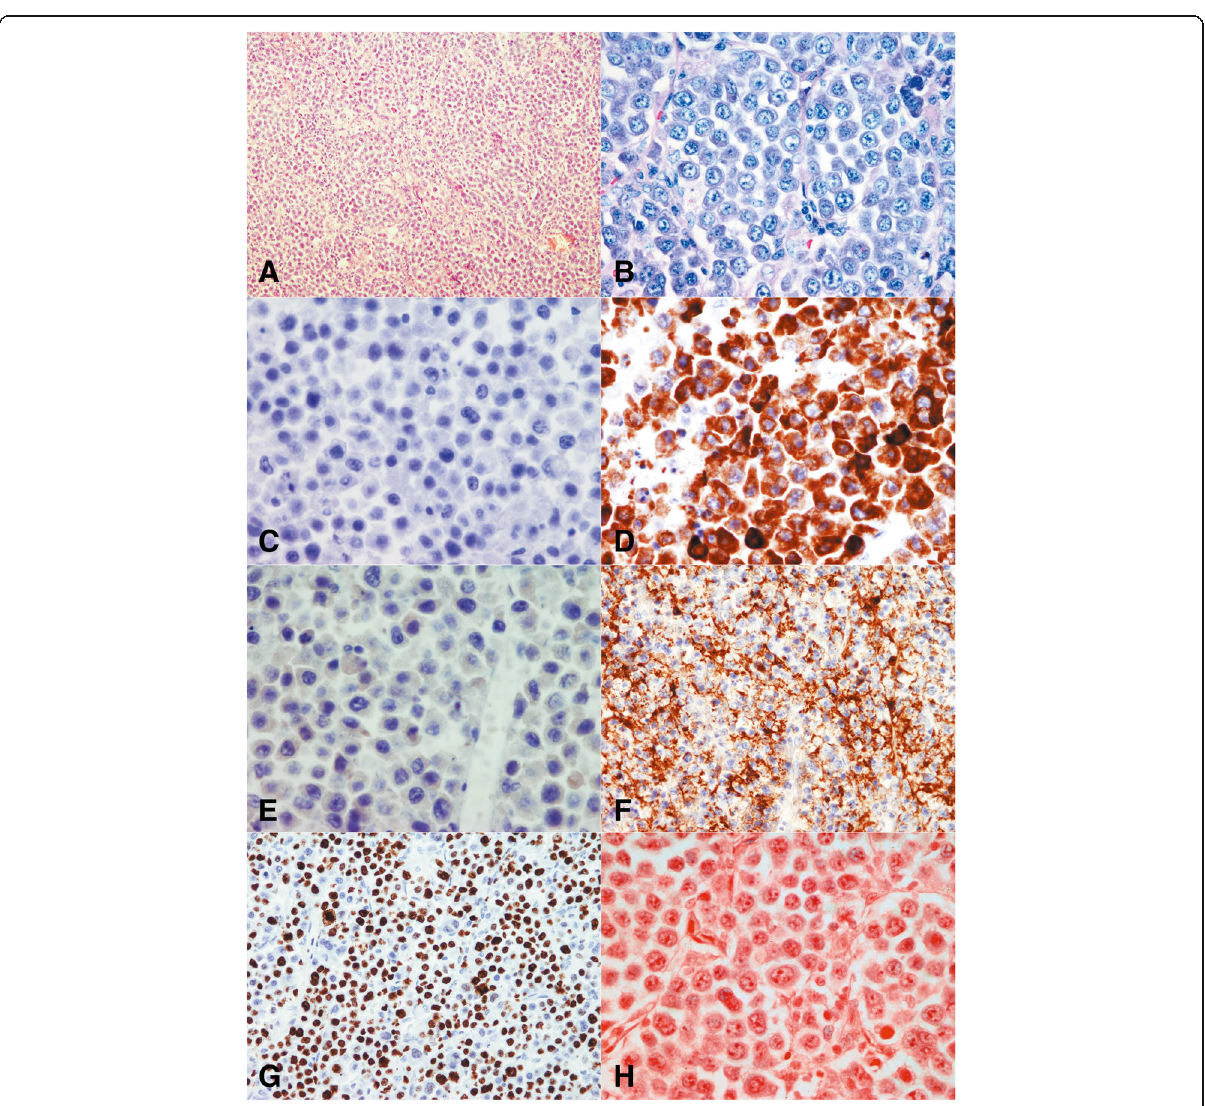
Fig. 2 Histology and immunohistochemisty of plasmablastic lymphoma. a Haematoxylin and eosin section shows monotonous, lymphoid cells with “ starry sky ” pattern (magnification ×100). b Giemsa staining highlights the plasmablastic appearance with eccentrically positioned nuclei, prominent nucleoli and abundant basophilic cytoplasm (magnification ×400). c - f Atypical lymphoid cells were negative for CD20 ( c ) and CD30 ( e ), while they were positive for CD79a ( d ) and CD138 ( f ) (immunoperoxidase stain; c , d and e magnification × 400; f magnification ×200). g Nuclear proliferation rate, assessed by Ki-67 was approximately 80% (immunoperoxidase stain; magnification × 200). h EBV encoded RNA (EBER) was negative in the nuclei of the atypical cells (magnification